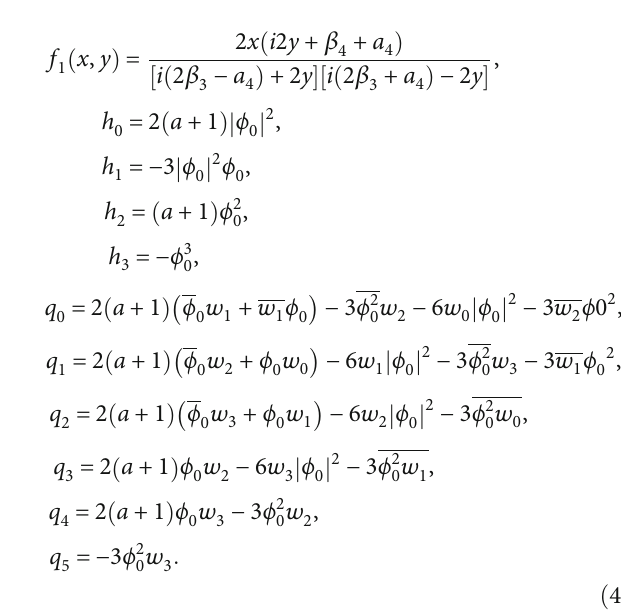
in Equation (3) with I = 0 . (a) The dynamics of u 1,2,3,4 with c = 0 : 18 . (d) The dynamics of u 1,3 ð 0 Þ = 0 : 01 4